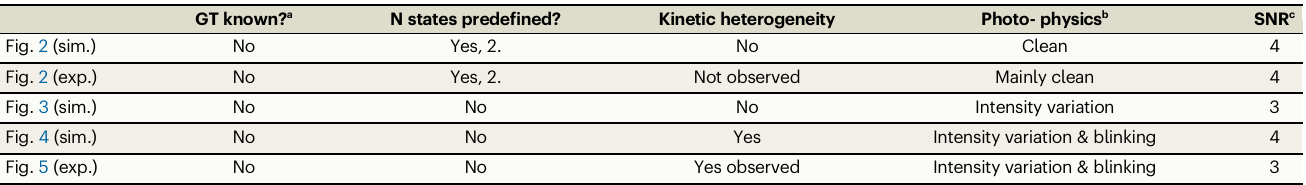
Table 3 | Summary of the test conditions for the individual datasets, including the prior information on ground truth (GT) and number (N) states, as well as three data characteristics: kinetic heterogeneity, photo-physics, and signal-to-noise ratio